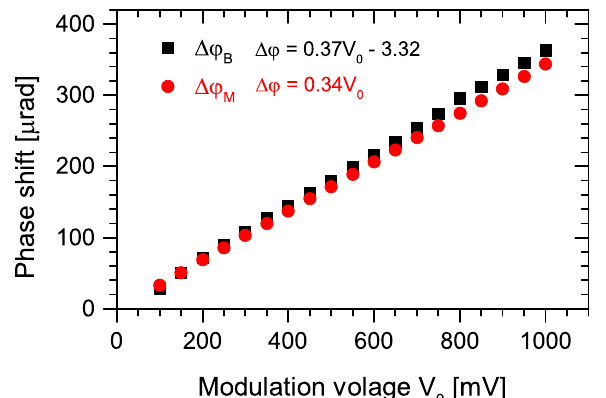
Figure 20. ( A ) The sample of detected beat note signal for modulation signal amplitude 275mV. ( B ) spectrum of the beat note signal calculated using FFT from 20 s beat note record, frequency 460 Hz. The beat note bandwidth at ∼ 20 dB was 4.3 Hz.